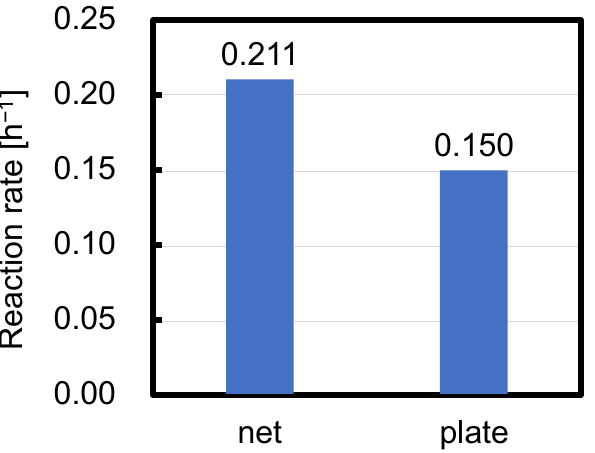
Figure 4. Photocatalytic degradation of MB by a TiO 2 -coated net and a TiO 2 -coated plate.